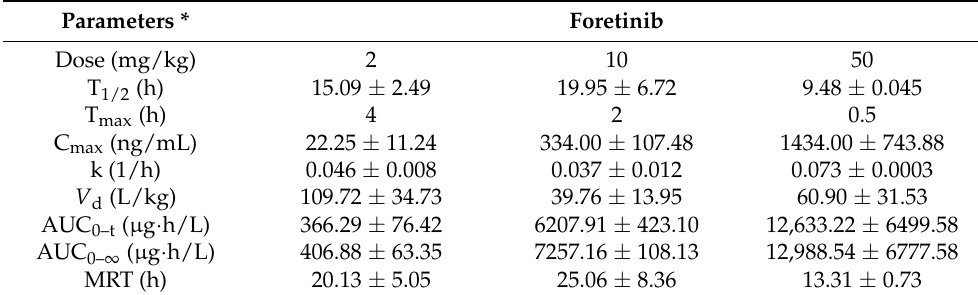
Figure 2. The pharmacokinetic characteristics of foretinib in tumor-bearing mice. The squares, triangles, and circles represent the plasma concentrations of foretinib over time after intragastric administration in the tumor-bearing mice at the dosages of 2, 10, and 50 mg/kg, respectively. Table 1. Parameter estimates obtained from the pharmacokinetic analysis.